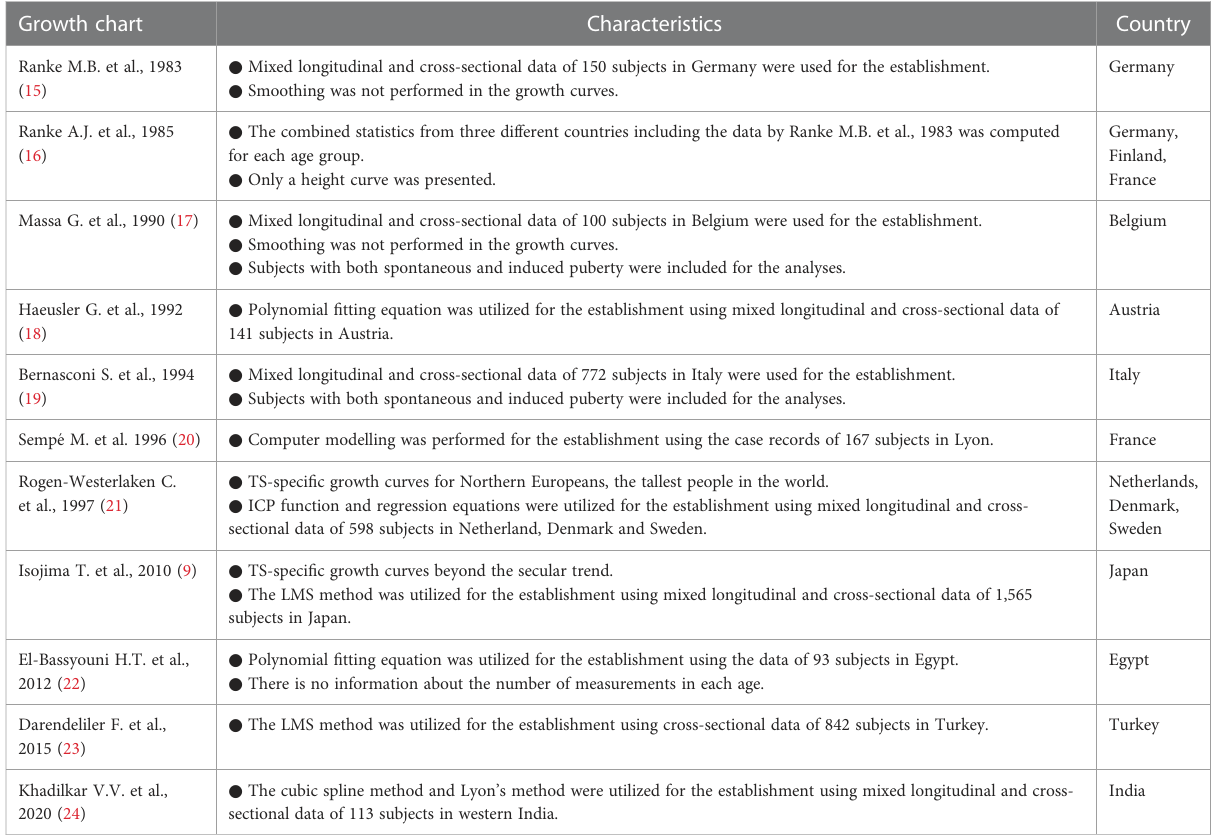
TABLE 1 The main characteristics of several TS-speci fi c growth